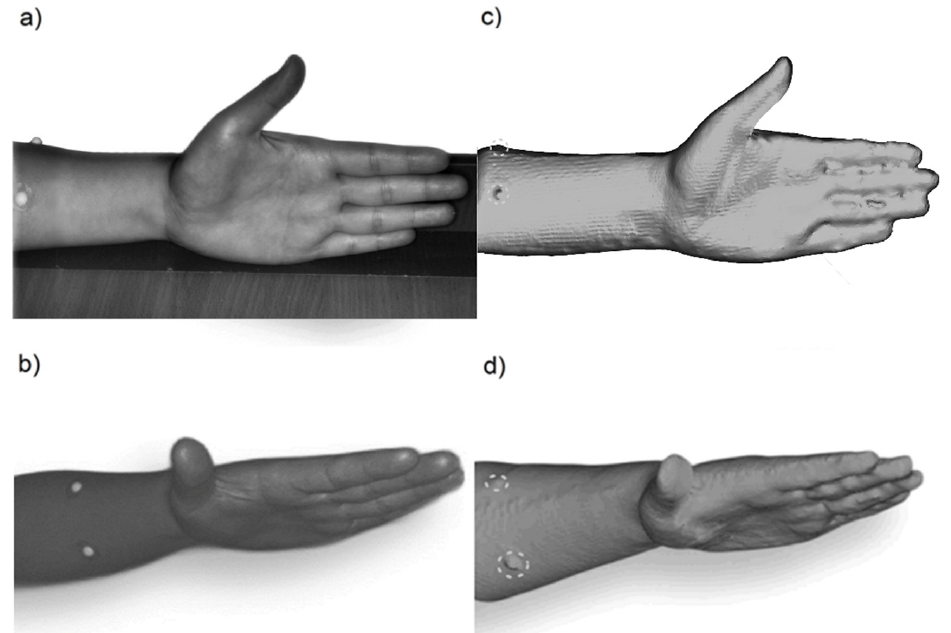
Figure 1. Bare hand with the palm rest surface used as a base for fixing the hand in the same position during the scanning and re-scanning procedure with landmarks supporting hand dimensioning ( a ) along with its image during the 3D scanning procedure ( a , b ) and corresponding 3D scans ( c , d ) with highlighted landmarks.